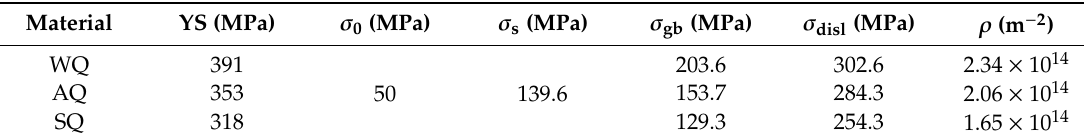
Table 2. Hardening constituents in the constitutive model and calculated dislocation density in ferritic phase.